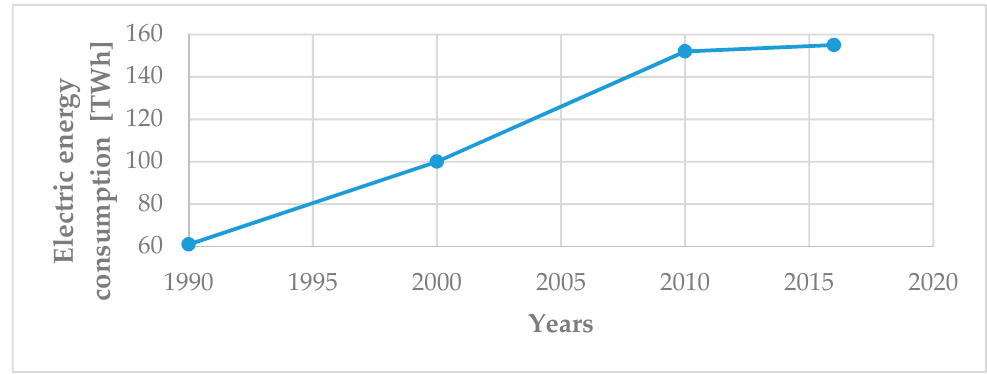
Figure 1. Consumption electricity for cooling buildings in the European Union [2].